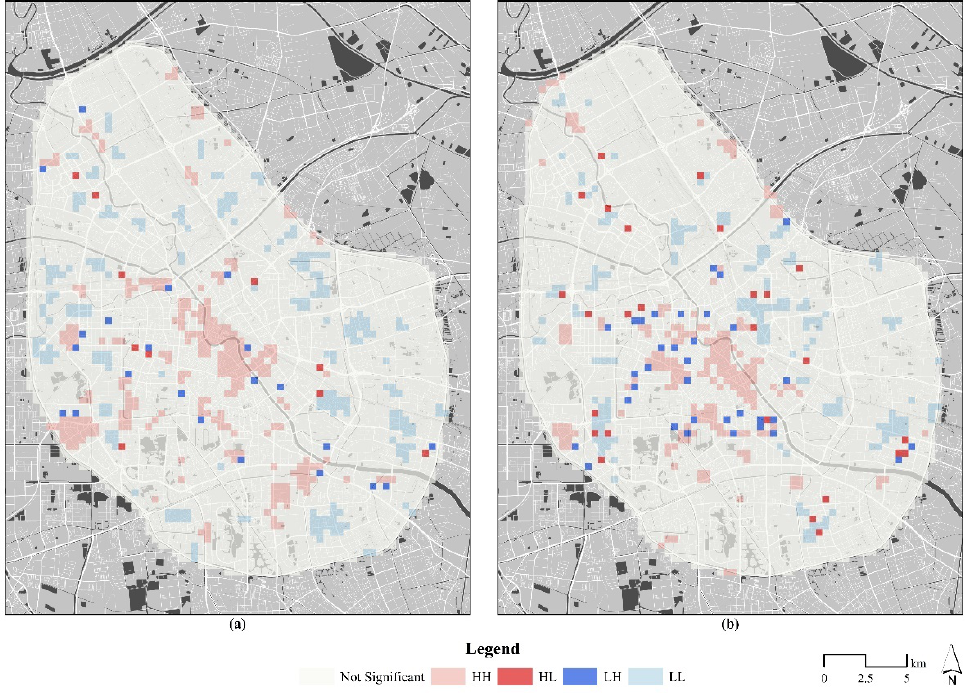
Figure 5. The local Moran’s I results during the pre-epidemic ( a ) and epidemic ( b )